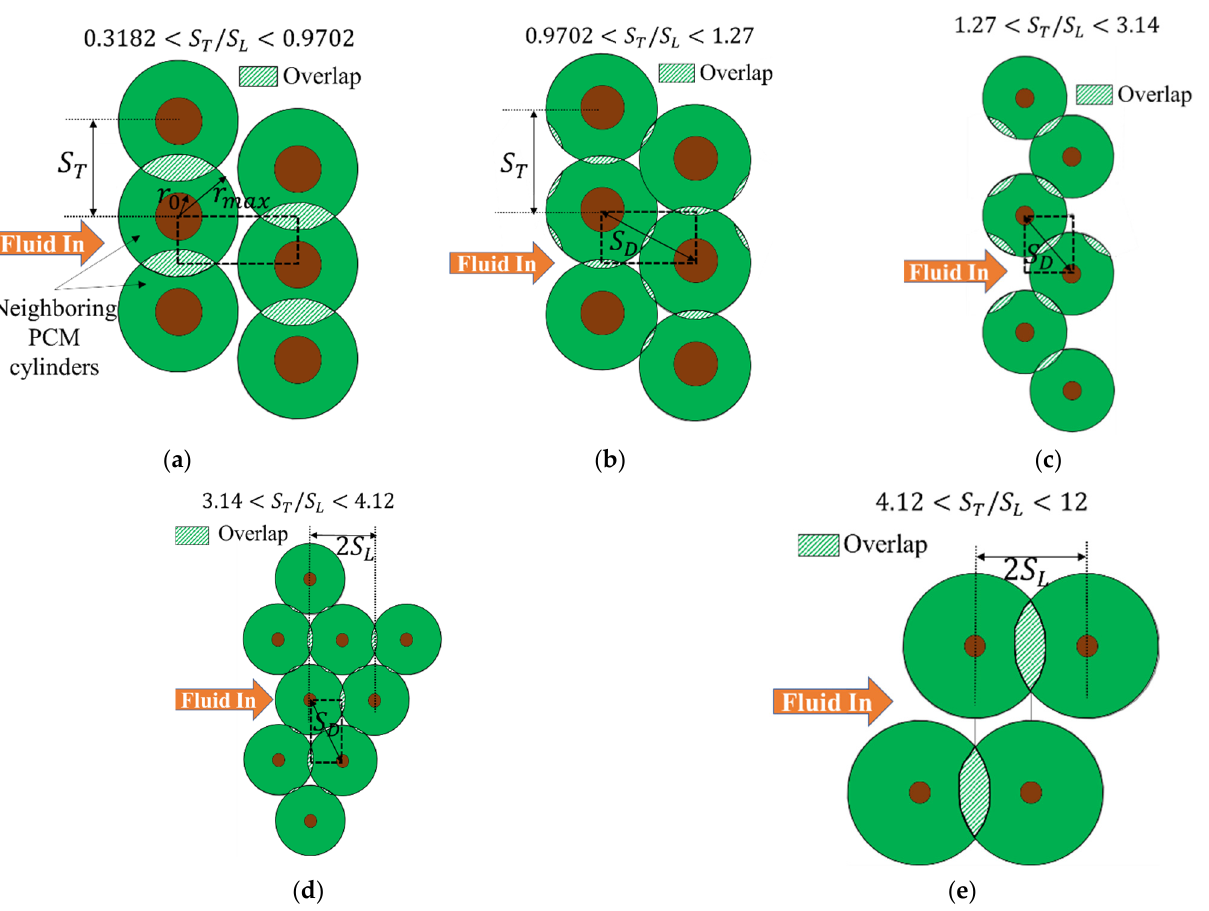
Figure 5. Range of 𝑆 (cid:3021) / 𝑆 (cid:3013) for different cases based on directions of overlap in 𝑆 (cid:3021) , 𝑆 (cid:3013) and 𝑆 (cid:3005) . ( a ) Figure 5. Range of S T / S L for different cases based on directions of overlap in S T , S L and S D . ( a ) S T 𝑆 𝑆 𝑆 𝑆 𝑆 𝑆 (cid:3021) controlled only. ( b ) (cid:3021) and (cid:3005) controlled. ( c ) (cid:3005) controlled only. ( d ) (cid:3005) and (cid:3013) controlled only. ( b ) S T and S D controlled. ( c ) S D controlled only. ( d ) S D and S L controlled. ( e ) S L controlled. ( e ) 𝑆 (cid:3013) controlled only. controlled